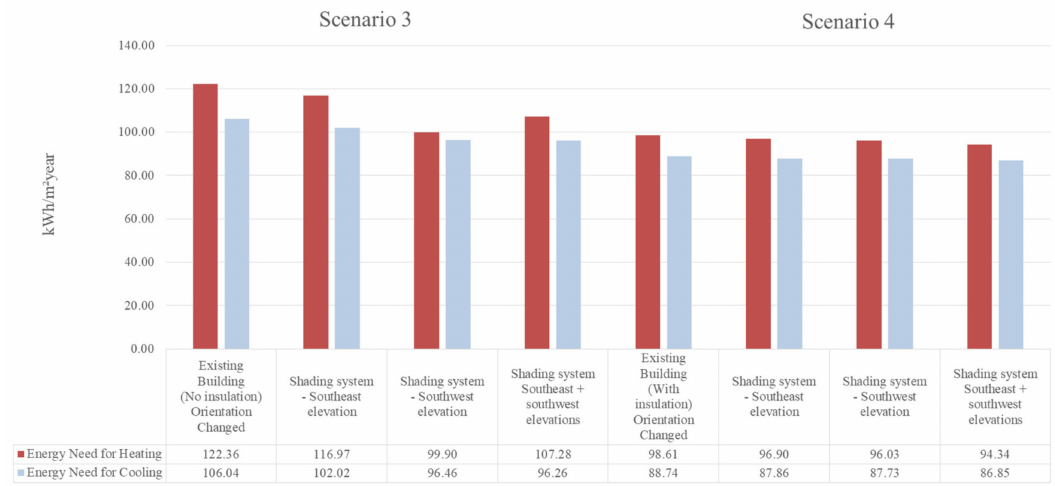
Figure 15. Calculation of the energy need (kWh/m 2 year) with DesignBuilder—scenarios 3 and 4. The results obtained with DesignBuilder, as shown in Table 3, indicate a different energy performance of the building in comparison to the tools previously used. In this new pattern, the energy need for heating improves by 27.65% and the energy need for cooling improves by 25.61% when the shading systems are taken into account (scenario 1). Table 3. Calculation of the improvement (%) of the shading system with the data obtained with DesignBuilder. The positive results (+) indicate an improvement and the negative results ( − ) indicate the opposite, i.e., the performance of the building is inferior when the shading system is